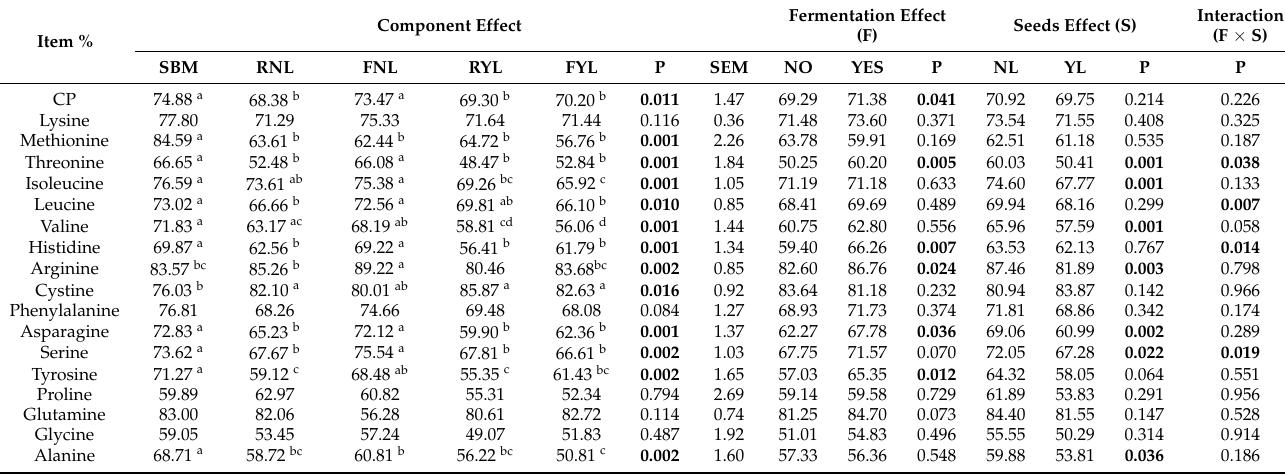
Table 4. The apparent ileal digestibility coefficients of protein and amino acids in raw and fermented lupine seeds and soybean meal ( n =